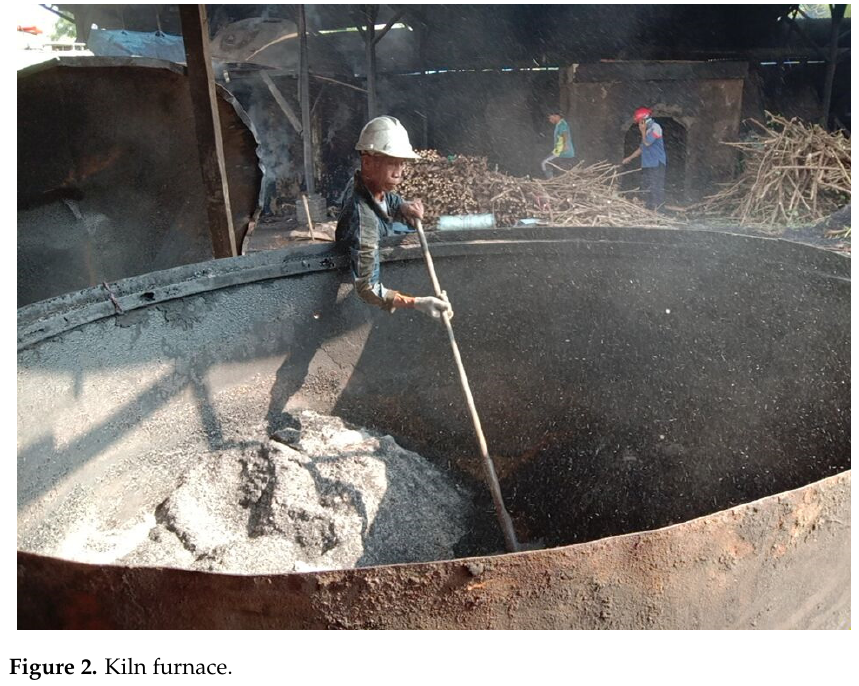
Figure 2. Kiln furnace.